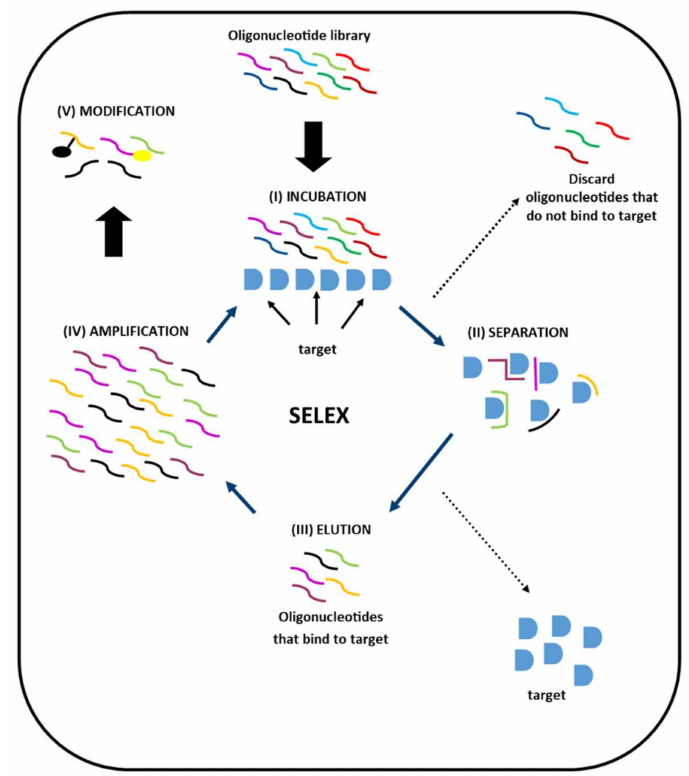
Figure 1. Summary of systematic evolution of ligands by exponential enrichment (SELEX) procedure for generation of aptamers for a specific target ligand. (I) Oligonucleotides from a library are incubated with the target. (II) Following incubation, oligonucleotides that do not bind to the target are separated from the bound oligonucleotide-target complexes and discarded. (III) Oligonucleotides that bind to the target are eluted. (IV) The eluted oligonucleotides are then amplified and incubated with the target. (I) The cycle is then repeated several times, with increased stringency of the elution conditions during subsequent cycles, to produce an enriched pool of the best candidate oligonucleotides. (V) After the last cycle, the selected oligonucleotides are then assessed, and the sequences with the highest binding a ffi nity are selected and synthesised. These sequences can then be modified by addition of groups to the 3 (cid:48) -end to reduce their susceptibility to nucleases, alteration of nucleotide bases and / or generation of spigelmers (i.e., mirror-image